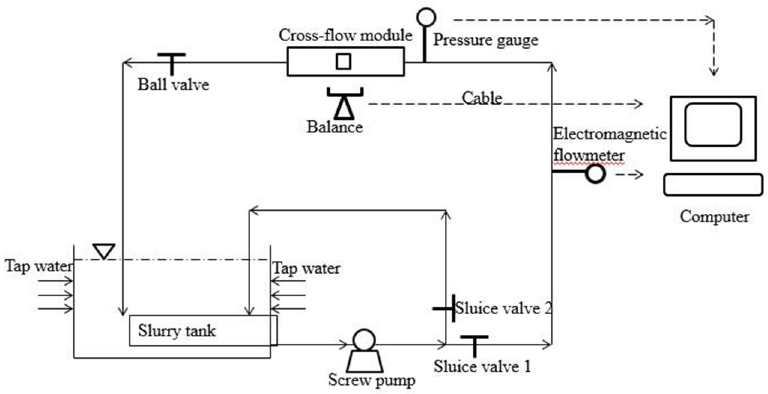
Figure 2. Schematic diagram of crossflow filtration experimental model.